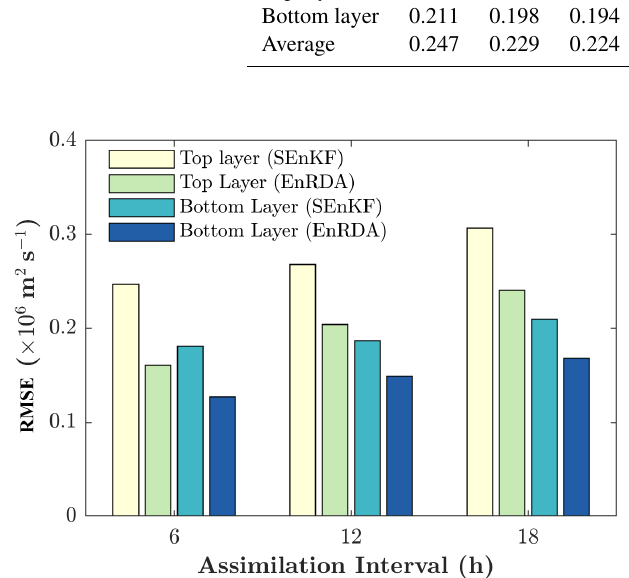
Figure 8. The average RMSE values as a function of assimilation intervals 6, 12 and 18h in the SEnKF and EnRDA for the two-layer quasi-geostrophic